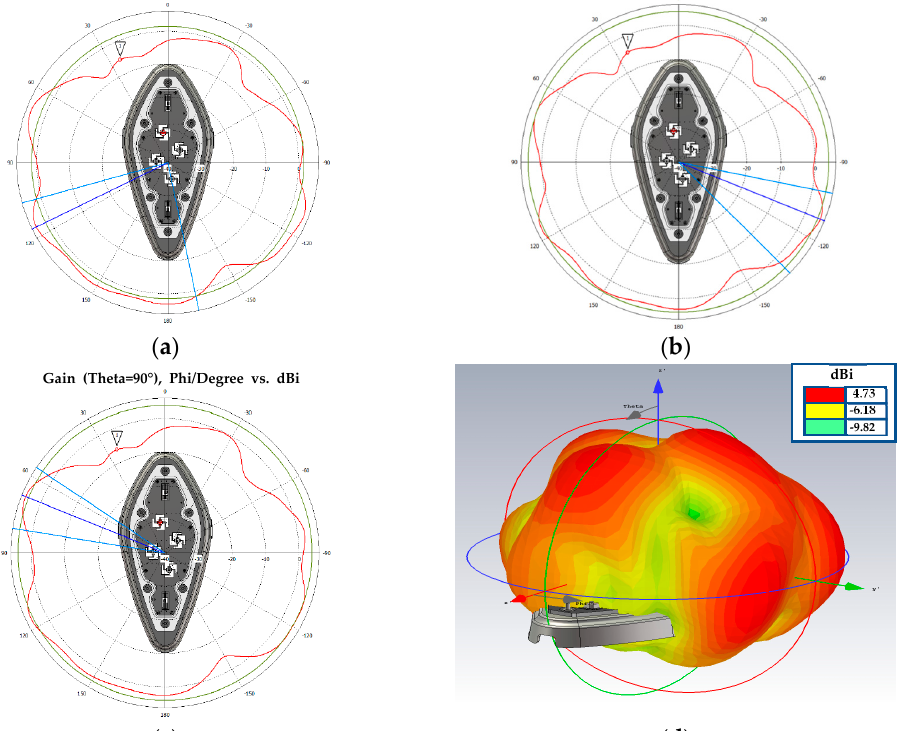
Figure 6. Radiated beam patterns obtained from monopole WAVE antenna with quadruple closed- loop devices on the shark-fin module at the angles of ( a ) 80 ◦ , ( b ) 85 ◦ , and ( c ) 90 ◦ ; and ( d ) 3D view.